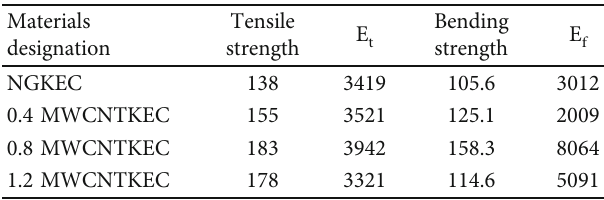
Table 4: Reinforcement of NGKEC with NEAT and multiwalled carbon nanotubes.